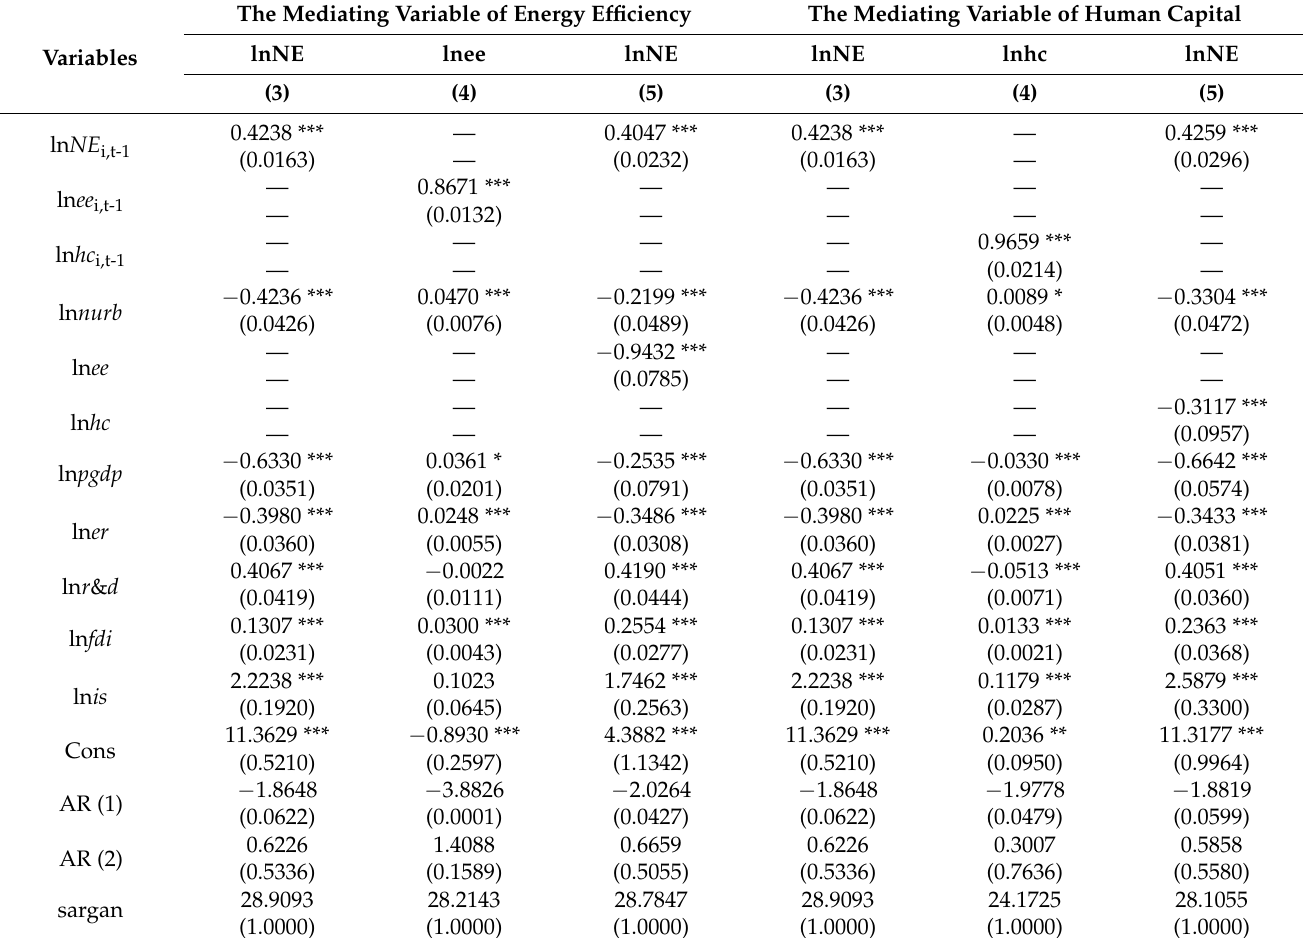
Table 5. Research results on the mechanism of NOx emissions by new